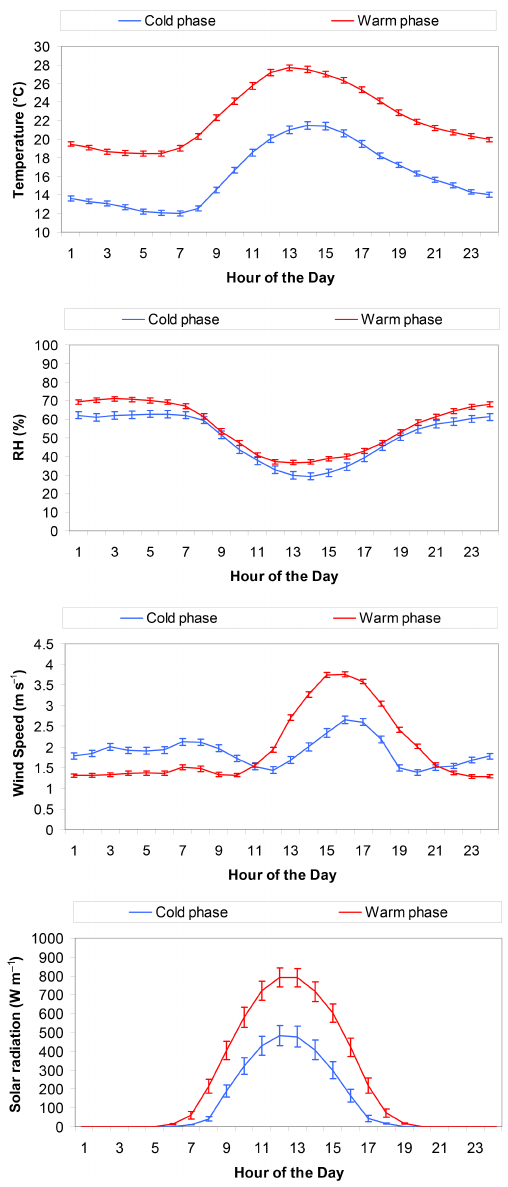
Figure 1. Diurnal variations of important meteorological parame- ters in the cold and warm phases. Error bars correspond to 1 stan- dard